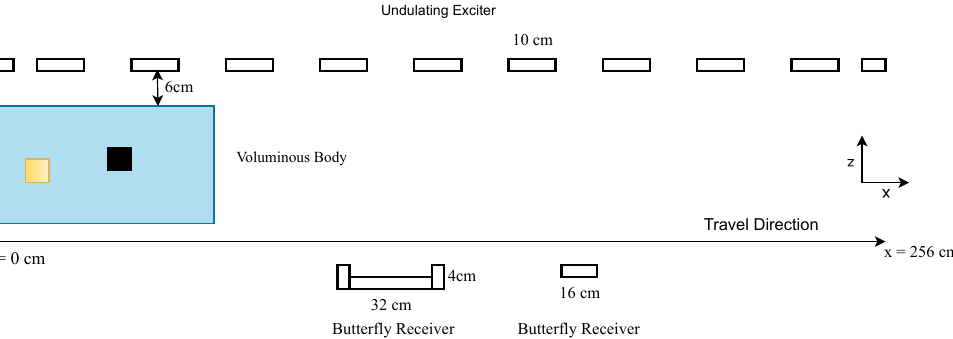
Figure 1. MIT setup used. A given body travels between the exciter and receiver arrays, and each cm in the x-position contributes one value to the total